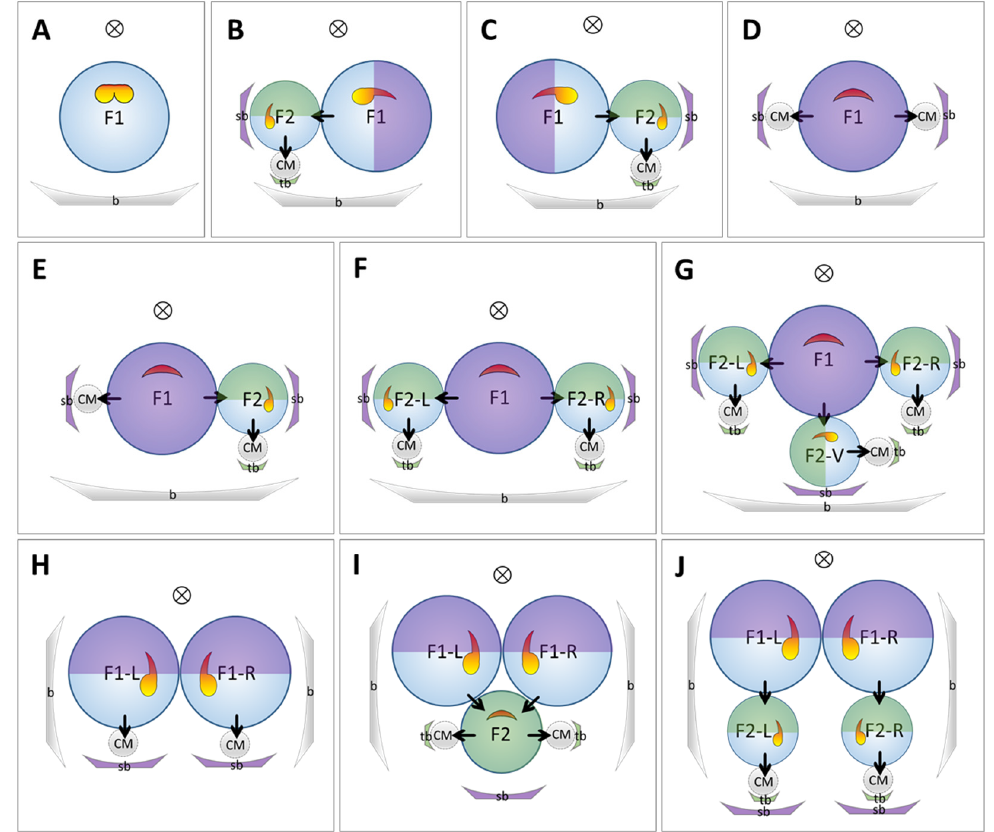
Figure 12. The correlation between the adaxial stamen form and the next order inflorescence branches. ( A ) Single flower (Ci-1); ( B ) Sinistrose cincinnus (normal type); ( C ) Dextrorse cincinnus; ( D ) 1- flowered cyme (Ci-2 and Ci-3); ( E ) 2-flowered cyme (Ci-4); ( F ) 3-flowered cyme (Ci-5); ( G ) 4-flowered cyme (Cg-7); ( H ) 2-flowered thyrse (Ci-6); ( I ) 3-flowered thyrse (Ci-7); ( J ) 4-flowered thyrse (Ci-8 and Cg-8). Small arrows within a partial inflorescence indicate the developing sequence of the flowers. The half in the primary flower distal to the secondary bract is shaded with purple, and the half in the secondary flower distal to the tertiary bract is shaded with